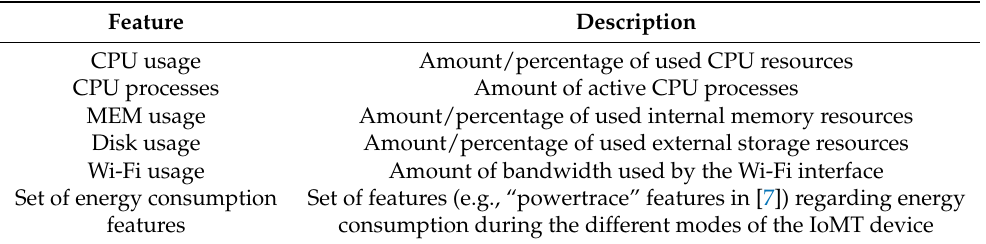
Table 5. Summary of features collected by the data collection module of the MDA component and their